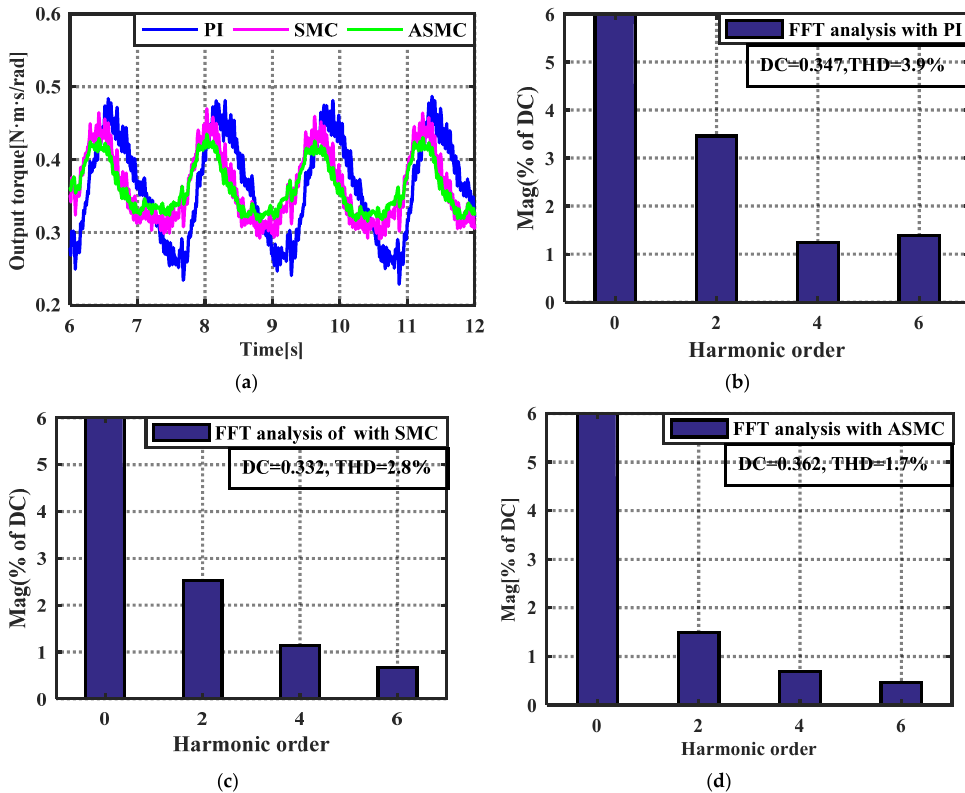
Figure 15. Output torque curves with three control methods and their FFT analysis. ( a ) Output torque curves using three control methods; ( b ) FFT analysis of the output torque with PI controller; ( c ) FFT analysis of the output torque with SMC; ( d ) FFT analysis of the output torque with ASMC.